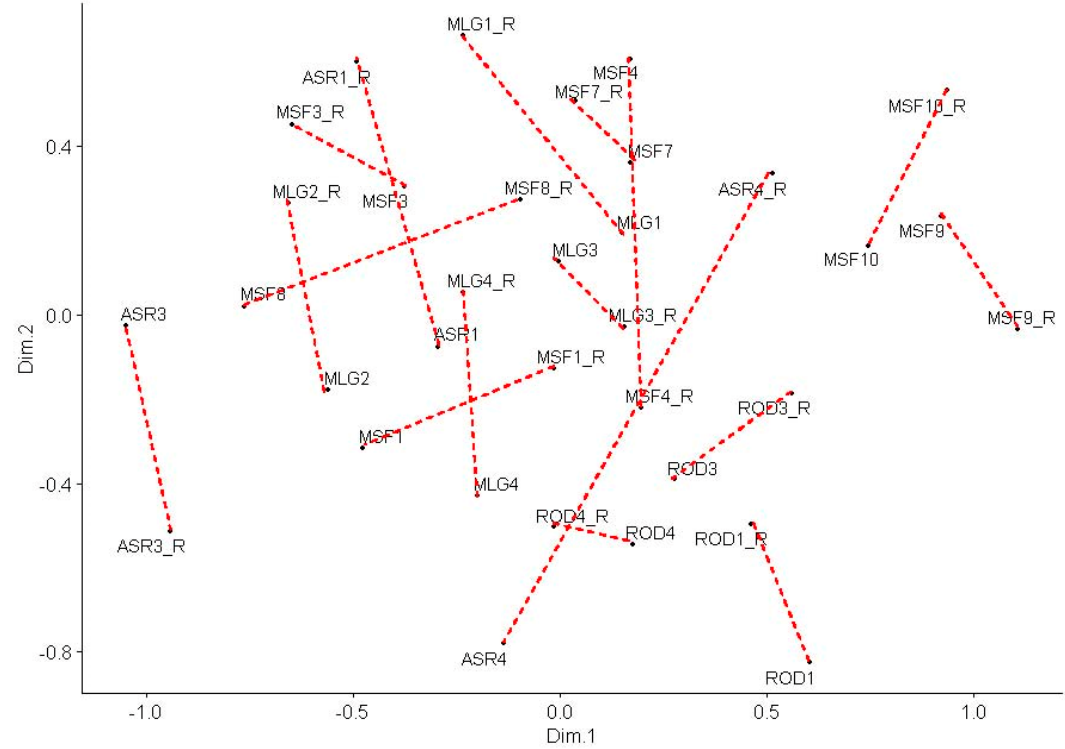
Figure 1. Multidimensional scaling for the first and second evaluation (using the chi-square distance between wines) based on Sammon’s non-linear